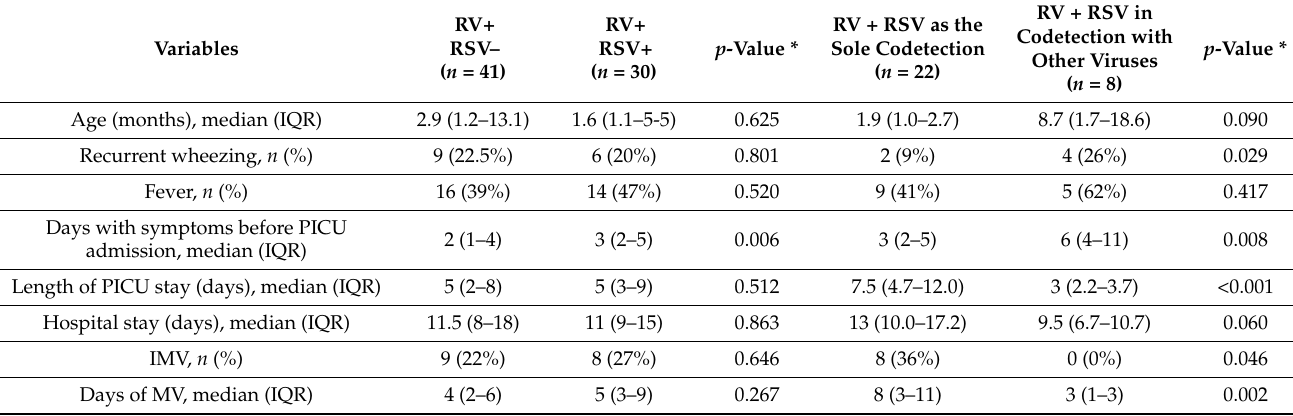
Figure 3. Number of detections of each EV/RV species per month. Table 2. Main demographic and clinical characteristics of children with RV/EV infection, according to RSV